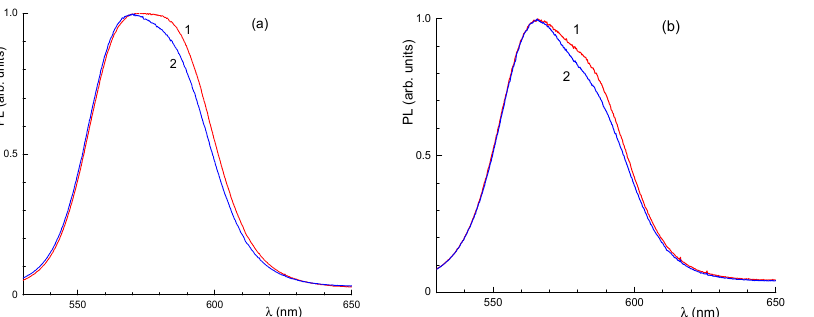
Figure 12. Photoluminescence spectra for films before (1) and after annealing at 120 °C (2) of CdSe/ZnS QDs and M1 ( a ) and T1 ( b ).